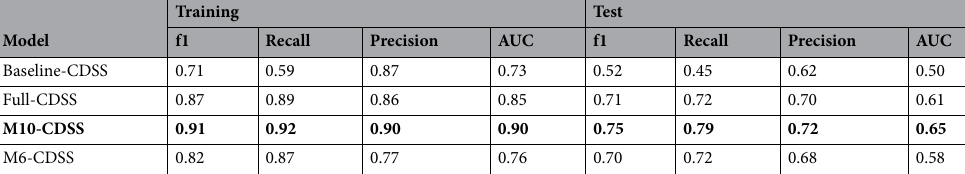
Table 4. Evaluation of the CDSS models. The “Baseline-CDSS” and “Full-CDSS” models use the whole dataset, while the numbers next to the remaining model names indicate the number of features they use that were selected based on importance. The best model is presented in bold. AUC is the Area Under the ROC (Receiver Operator Characteristic) Curve.